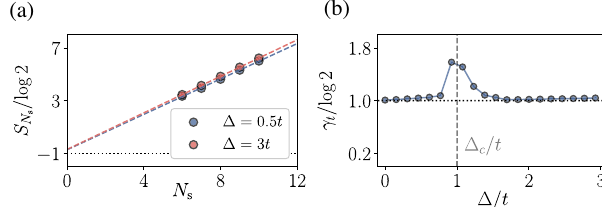
FIG. 7. Topological entanglement in the Creutz-Ising ladder. (a) Scaling of the entanglement entropy S h ¼ 0 . 02 t , and for different imbalances corresponding to the SPT ( Δ ¼ 0 . 5 t ) and TBI ( Δ ¼ 3 t ) phases. In both cases, the topo- logical correction to the entanglement entropy is γ signaling topological order. In panel (b), we represent this quantity as a function of Δ =t . The grey dashed line denotes the position of the first-order transition for a finite cylinder of 10 length N s ¼